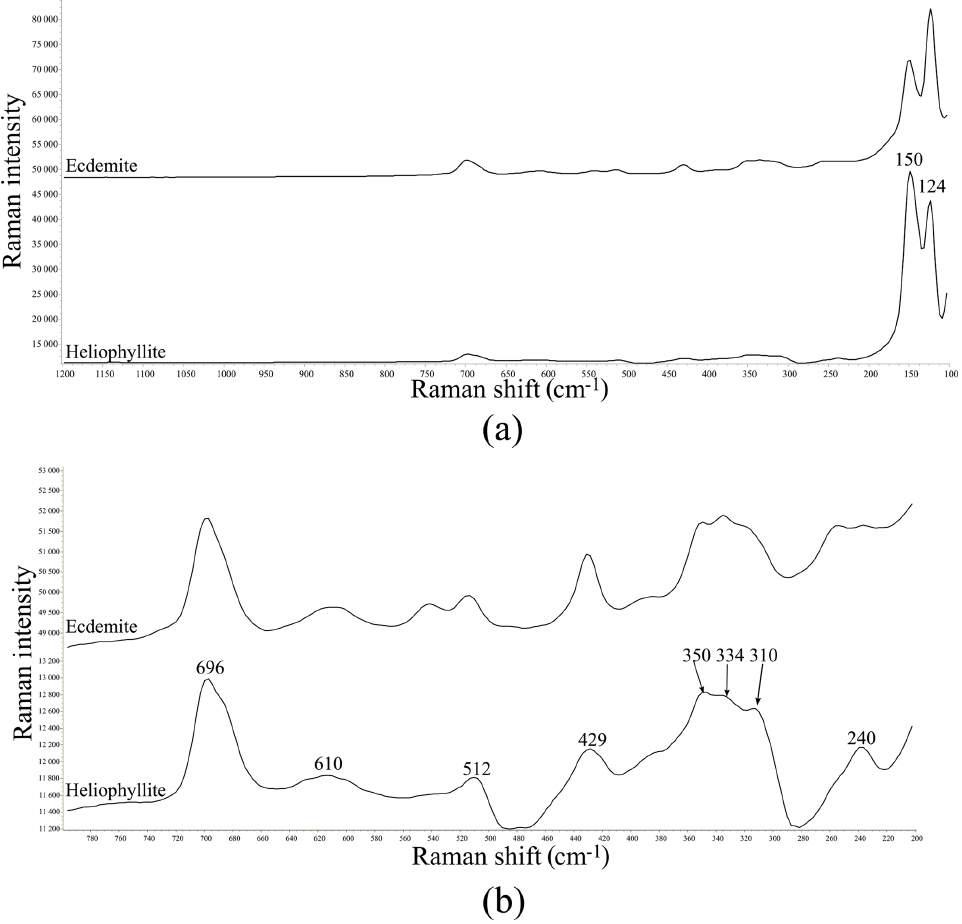
Figure 1. (a) Raman spectrum of heliophyllite holotype specimen NRM18880482 (lower spectrum) compared with the Raman spectrum of ecdemite specimen NRM19331765 from Harstigen (upper spectrum from Perchiazzi et al., 2019) in the range 100–1200cm − 1 . (b) Helio- phyllite: close-up of the spectral region between 200 and 800cm − 1